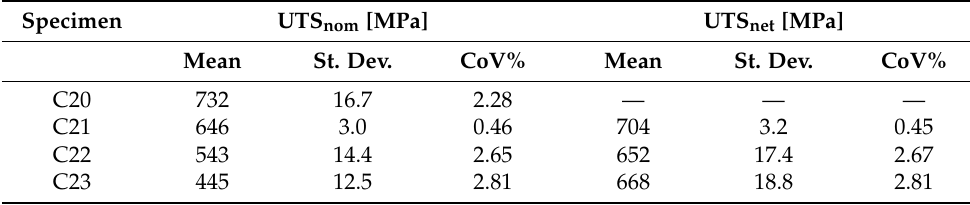
Table 2. Average failure data for three repetitions of the tensile test.